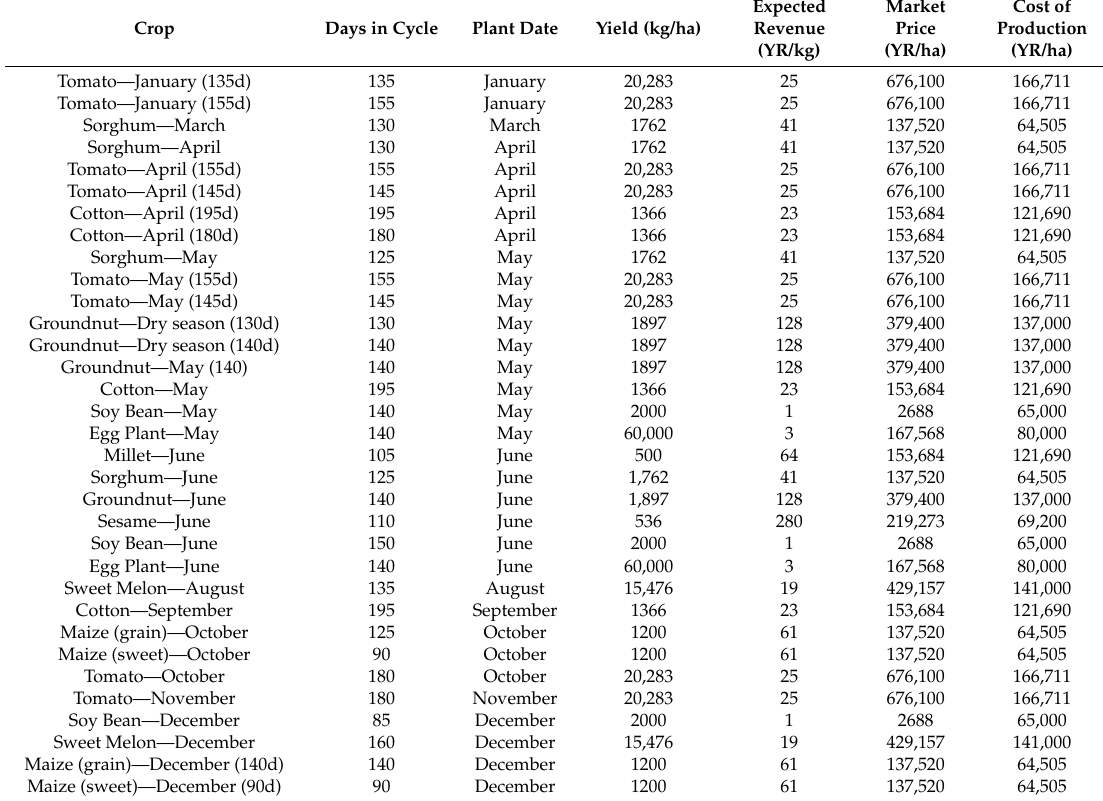
Table A4. Crop parameters for determining expected